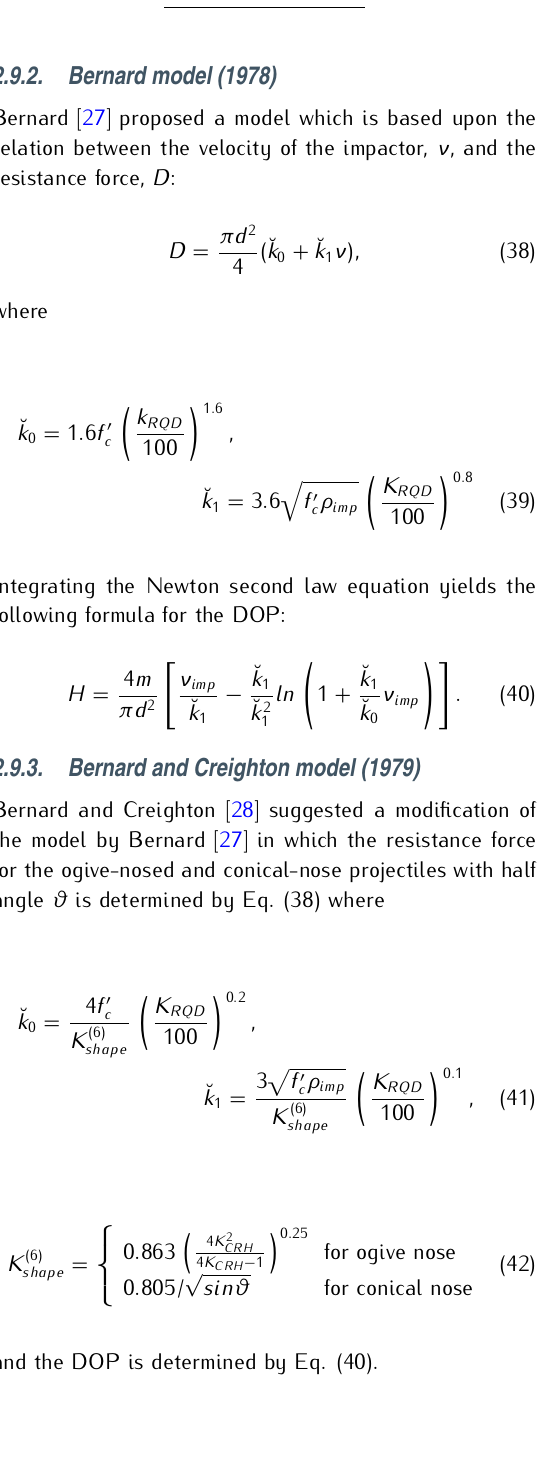
RQD and rock quality.